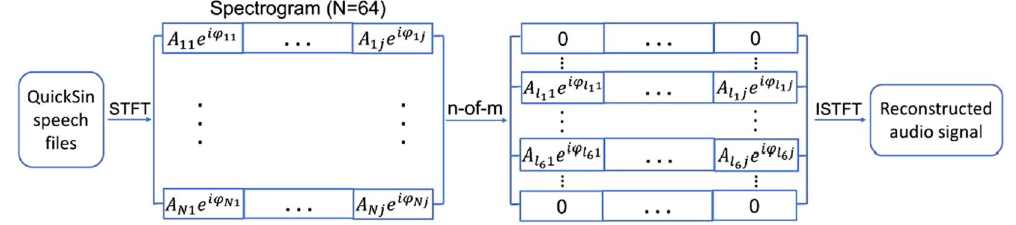
Figure 5. Flow-chart of signal reconstruction for TFS distortion. The input audio file was first analyzed by calculating the STFT. The resulting spectrogram contained 64 frequency bands. Applying the n-of-m method, the six frequency bands with highest energies were selected while eliminating other frequency bands to reconstruct new speech sentences. Magnitudes of selected channels were preserved, but phase values were modified under five conditions. The modified spectrogram was then used to reconstruct a new audio signal with phase